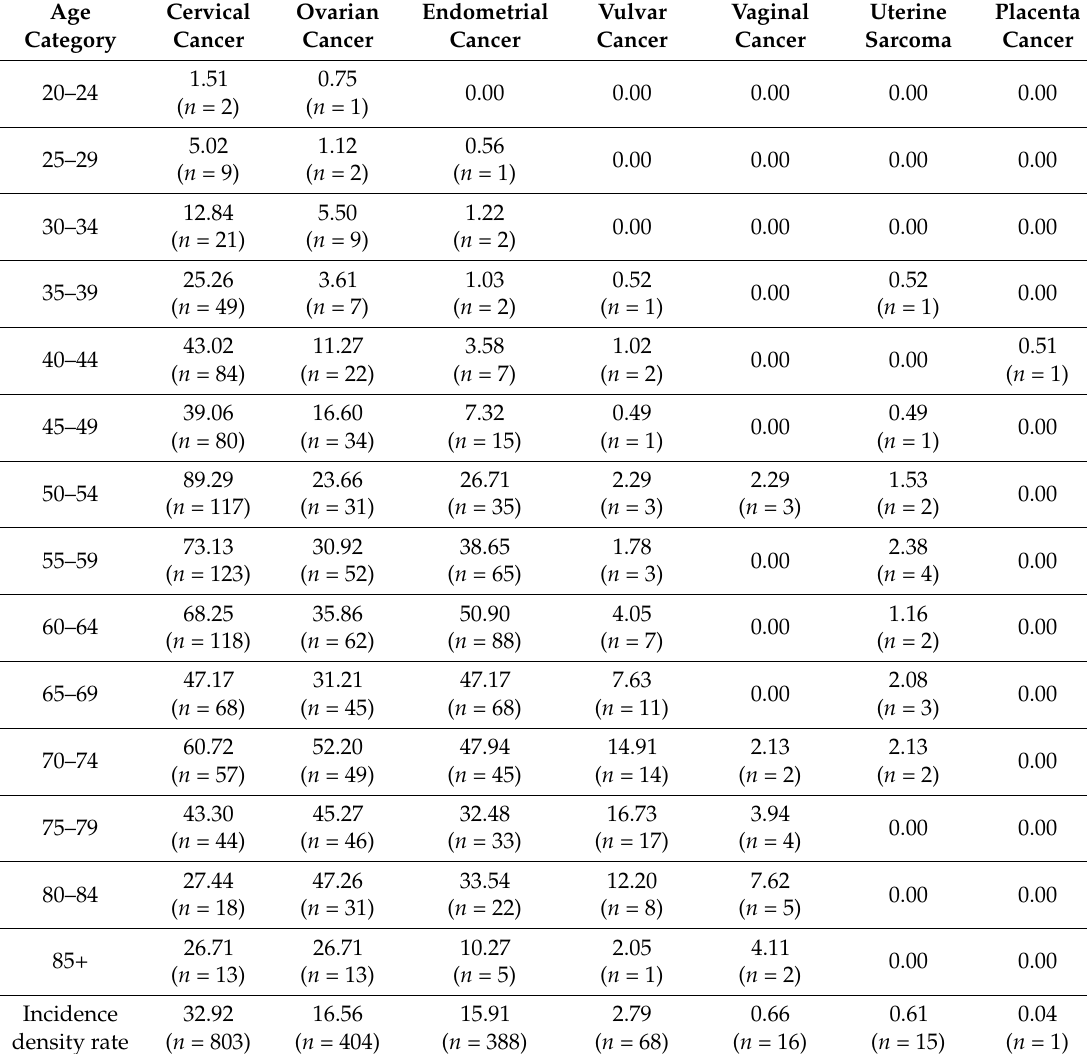
Table 1. Incidence density rate of genital cancer in women per